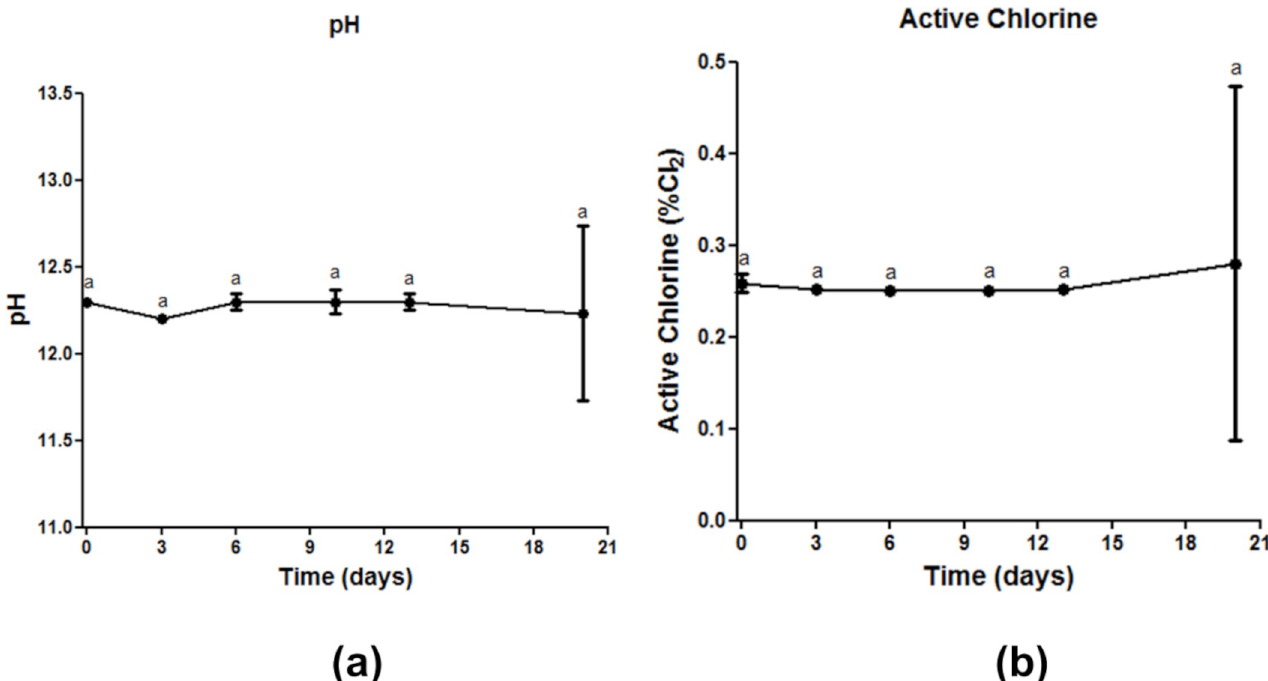
Fig 6. Stability analysis of sodium hypochlorite on days 0, 3, 6, 10, 13 and 20: (a) pH analysis and (b) percentage of active chlorine. There was no significant difference at p < 0.05 between values followed by the same letter according to Student’s t test with 95% confidence.